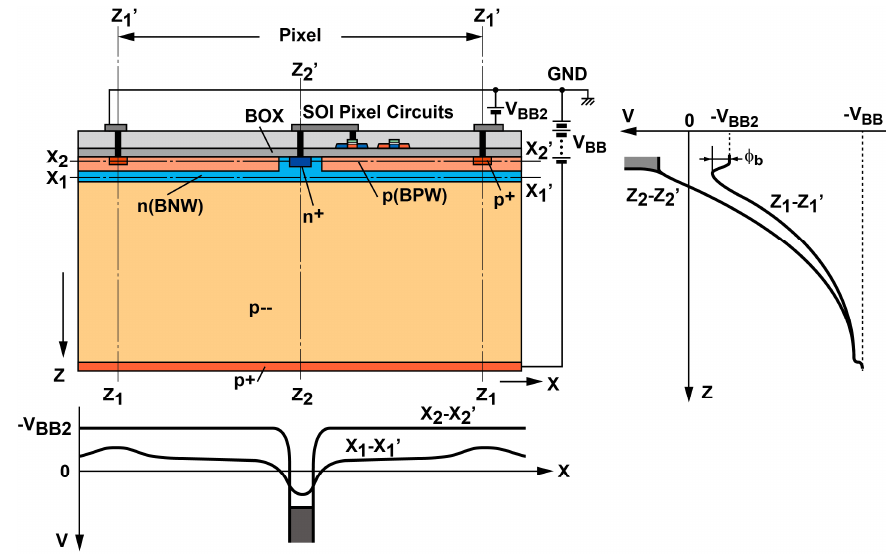
Figure 2. Cross-sectional view of the SOIPIX-PDD.